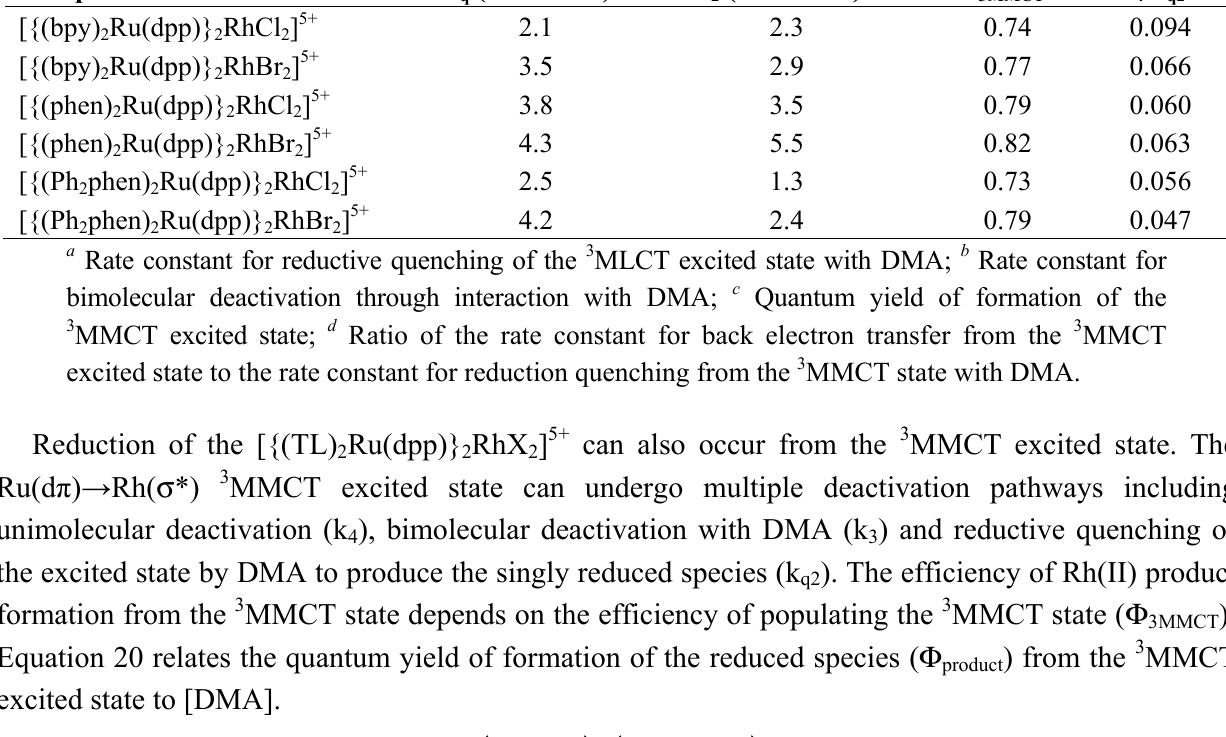
Ru(dpp)} RhX ](PF ) supramolecular 2 2 2 6 5